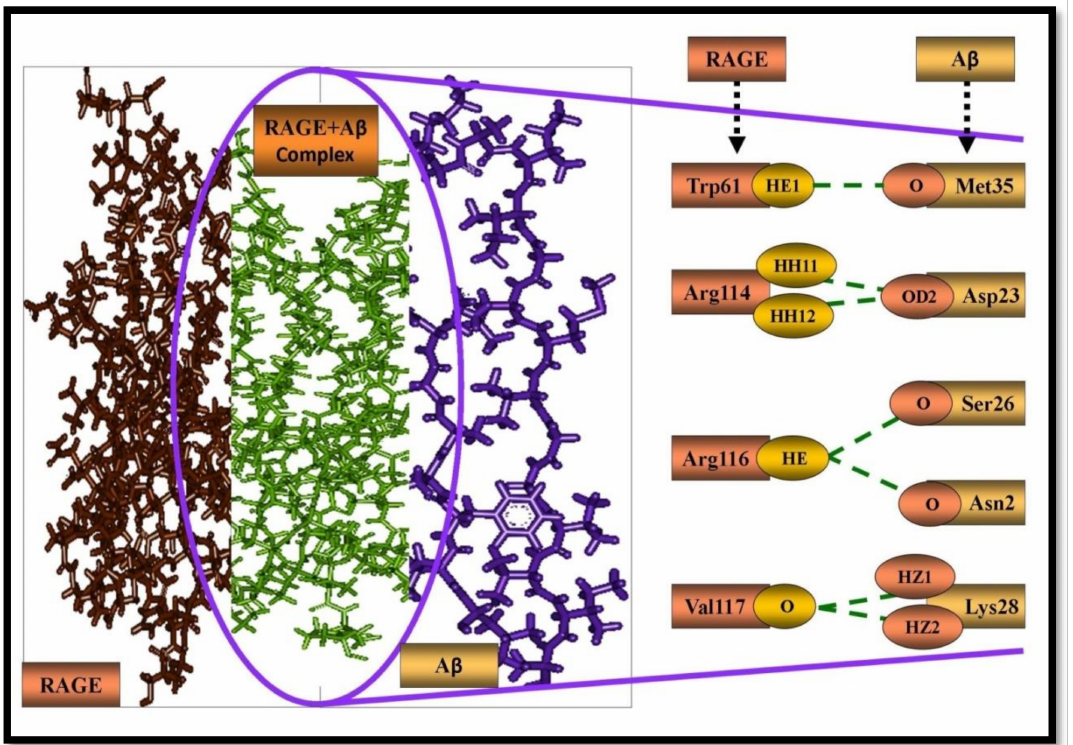
Figure 2. Protein-protein interaction. ( A ) A β , ( B ) RAGE, ( C ) the complex of A β and RAGE obtained by the protein-protein docking method. Purple and brown stick color representations are the amino acid residues of A β and RAGE, respectively, involved in H-bond